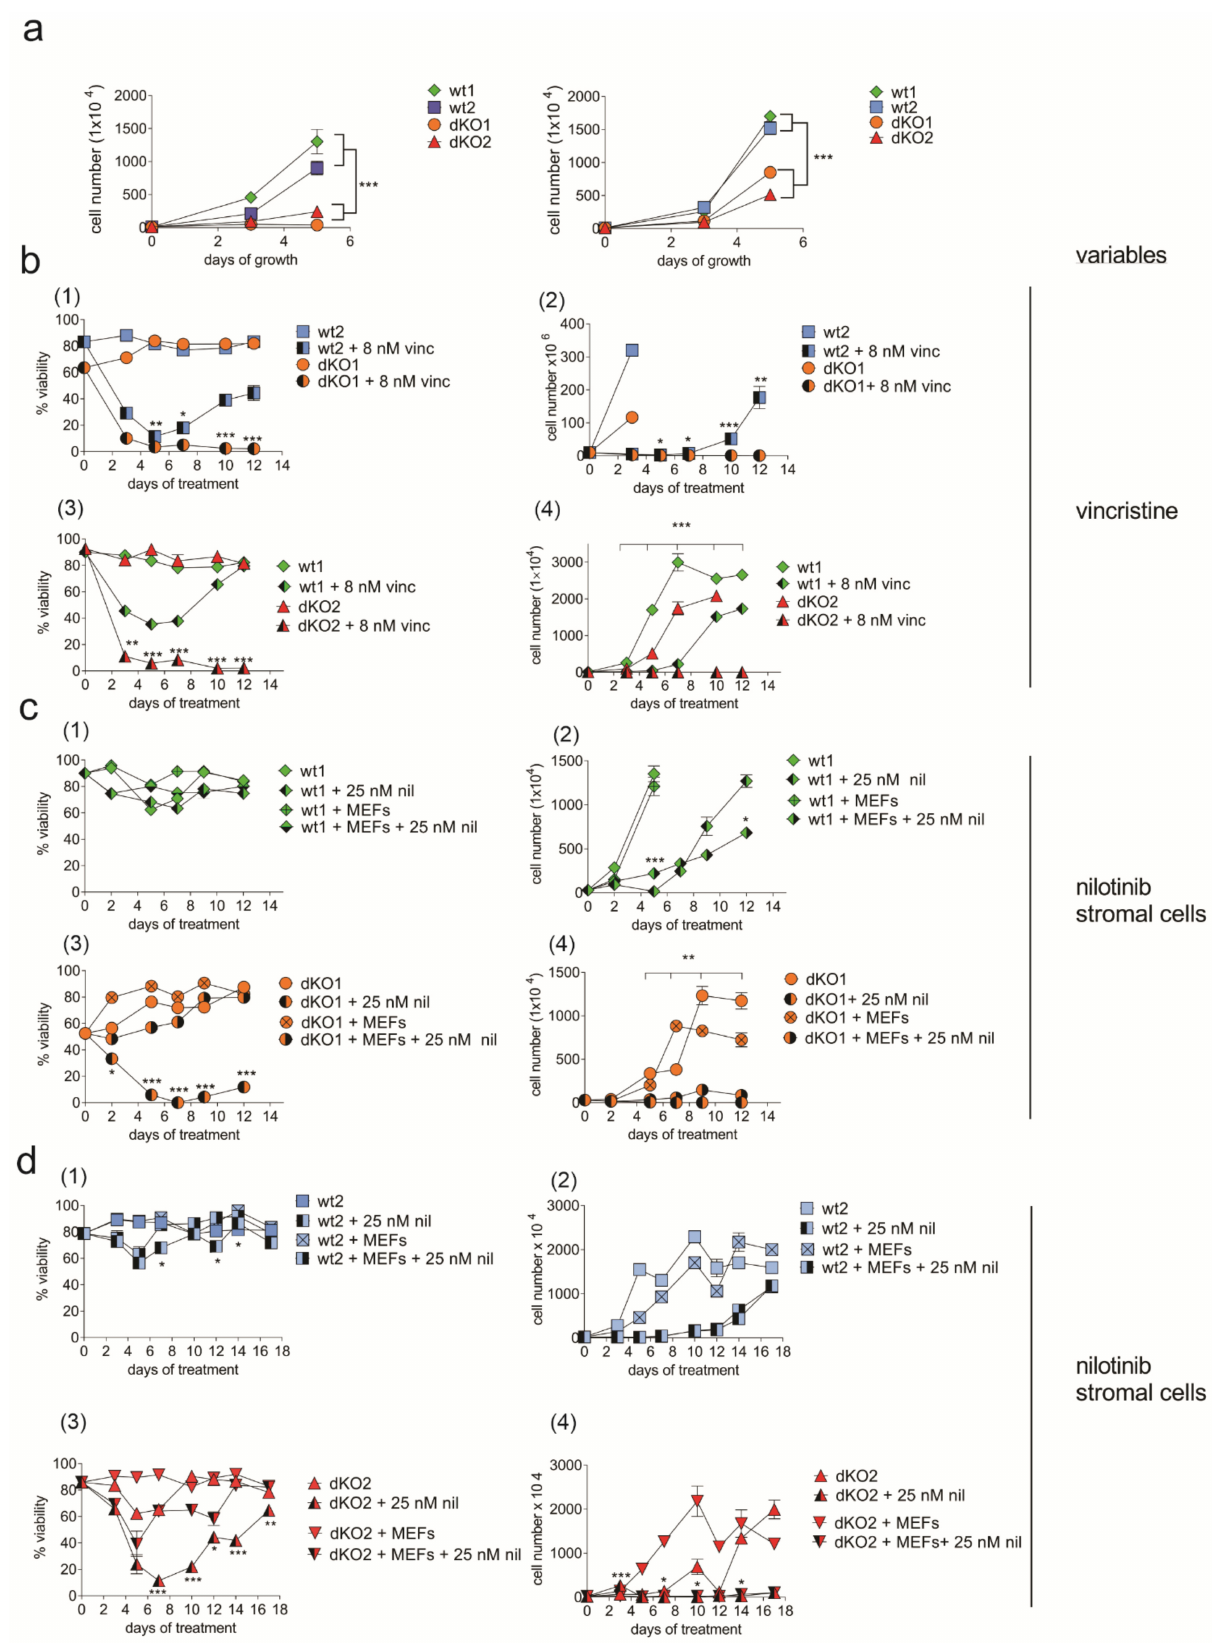
Figure 6. Murine Bcr/Abl-positive BCP-ALL cells lacking Galectin-1 and Galectin-3 have reduced growth and survival. ( a ) Proliferation as measured by viable cell counts of the indicated